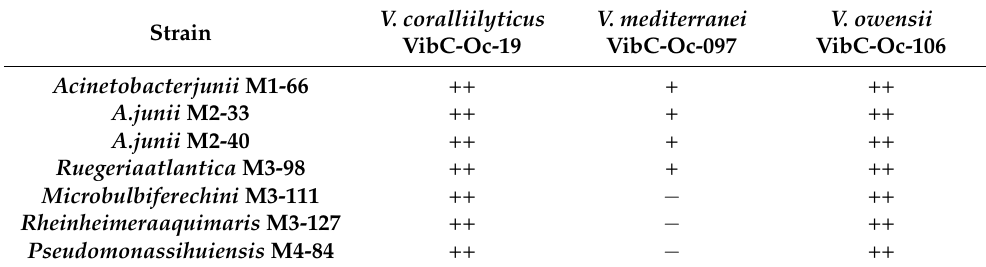
Table 2. Quorum quenching activity of marine strains against Vibrio spp. in coculture.